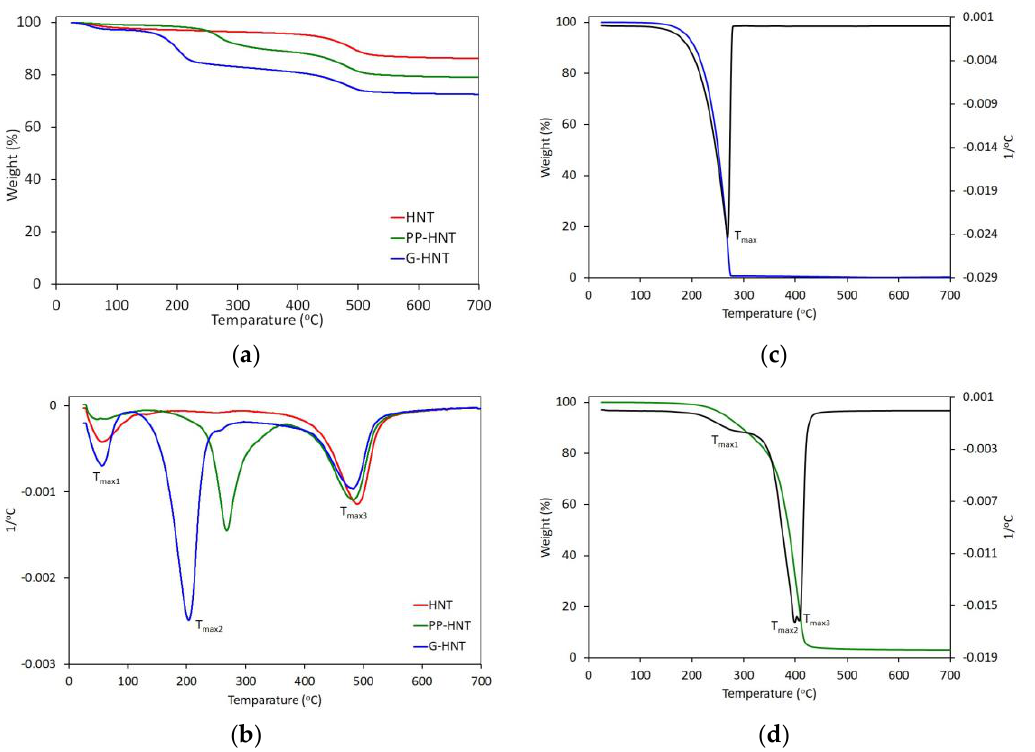
Figure 4. TG and DTG curves of halloysites ( a, b ), glycerol ( c ), and polyester plasticizer ( d ). The DSC curves of pure and modified HNT show phase change as a function of temperature (Figure 5). Pure HNT and G-HNT clearly show typical endothermic peaks at 106 ◦ C and 114 ◦ C, respectively, where absorbed water melts. In contrast, PP-HNT shows two endothermic peaks at 56 ◦ C and 88 ◦ C, which can also be attributed to the melting of absorbed water. These results are consistent with the FTIR observations and other studies [47,48].